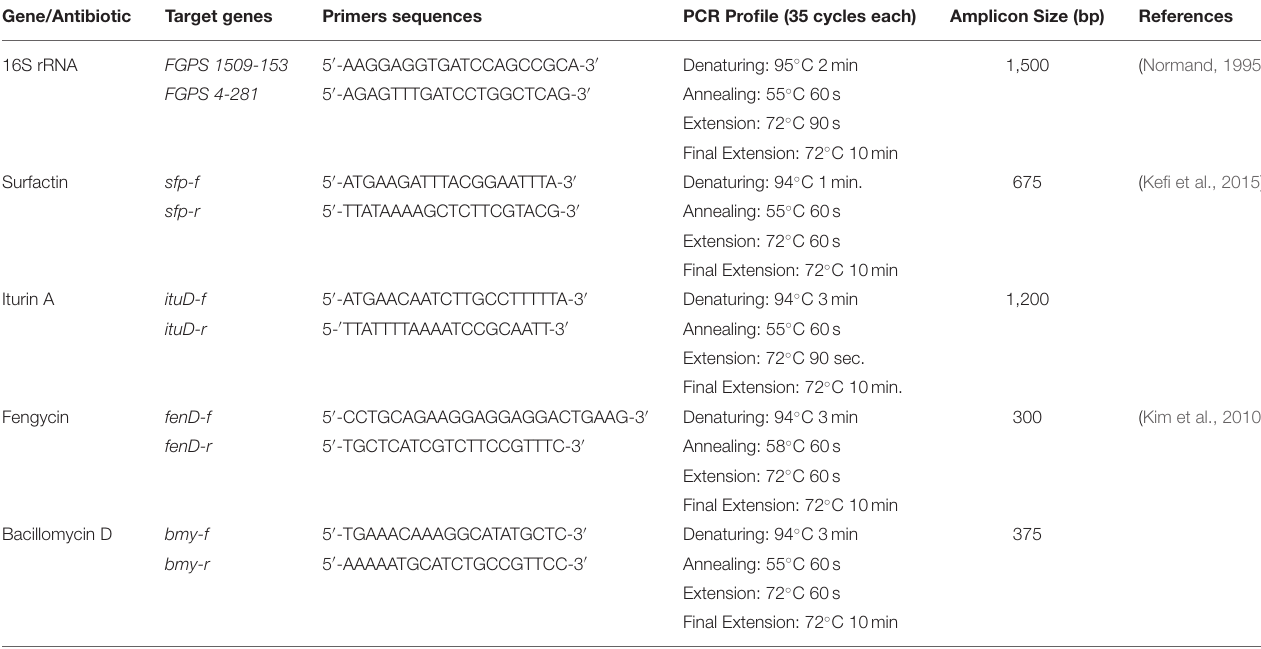
TABLE 1 | PCR conditions used for amplification of genes from Bacillus spp. Isolates. Gene/Antibiotic